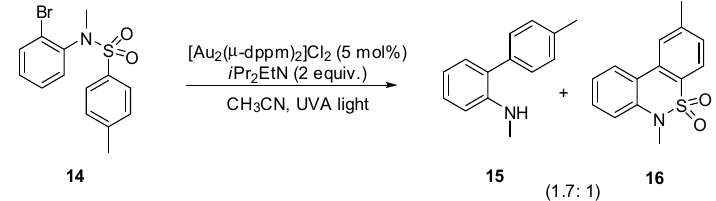
Scheme 12. Photoredox cyclization of arylbromide using a dimeric gold